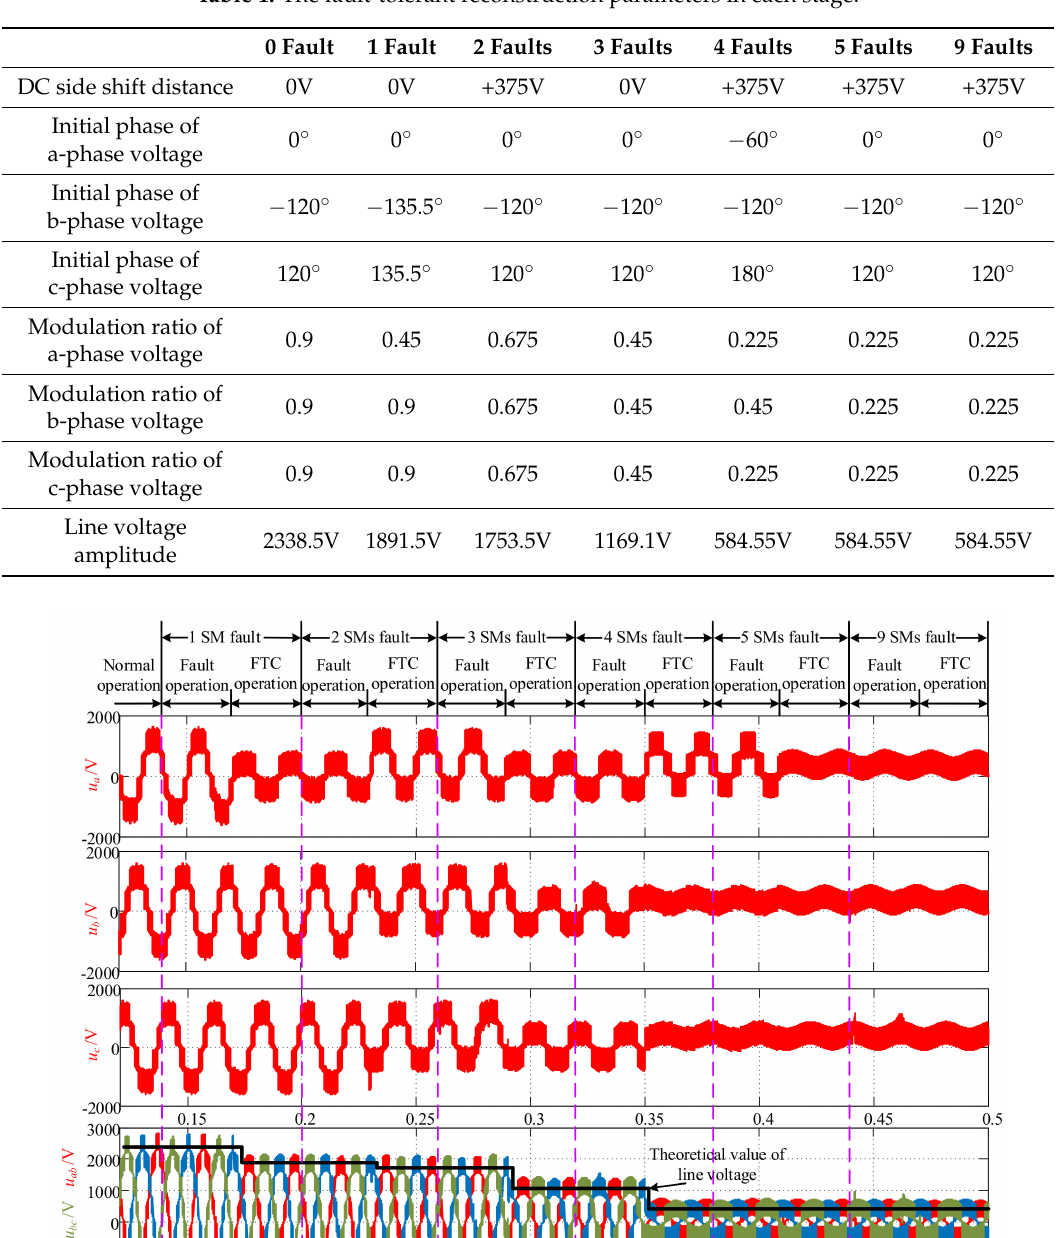
Table 1. The fault-tolerant reconstruction parameters in each stage.